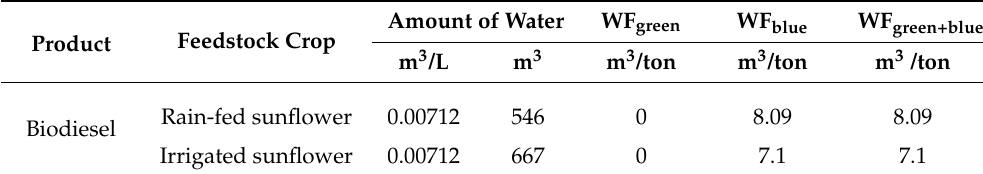
Table 4. Water footprint of biodiesel (processing level).